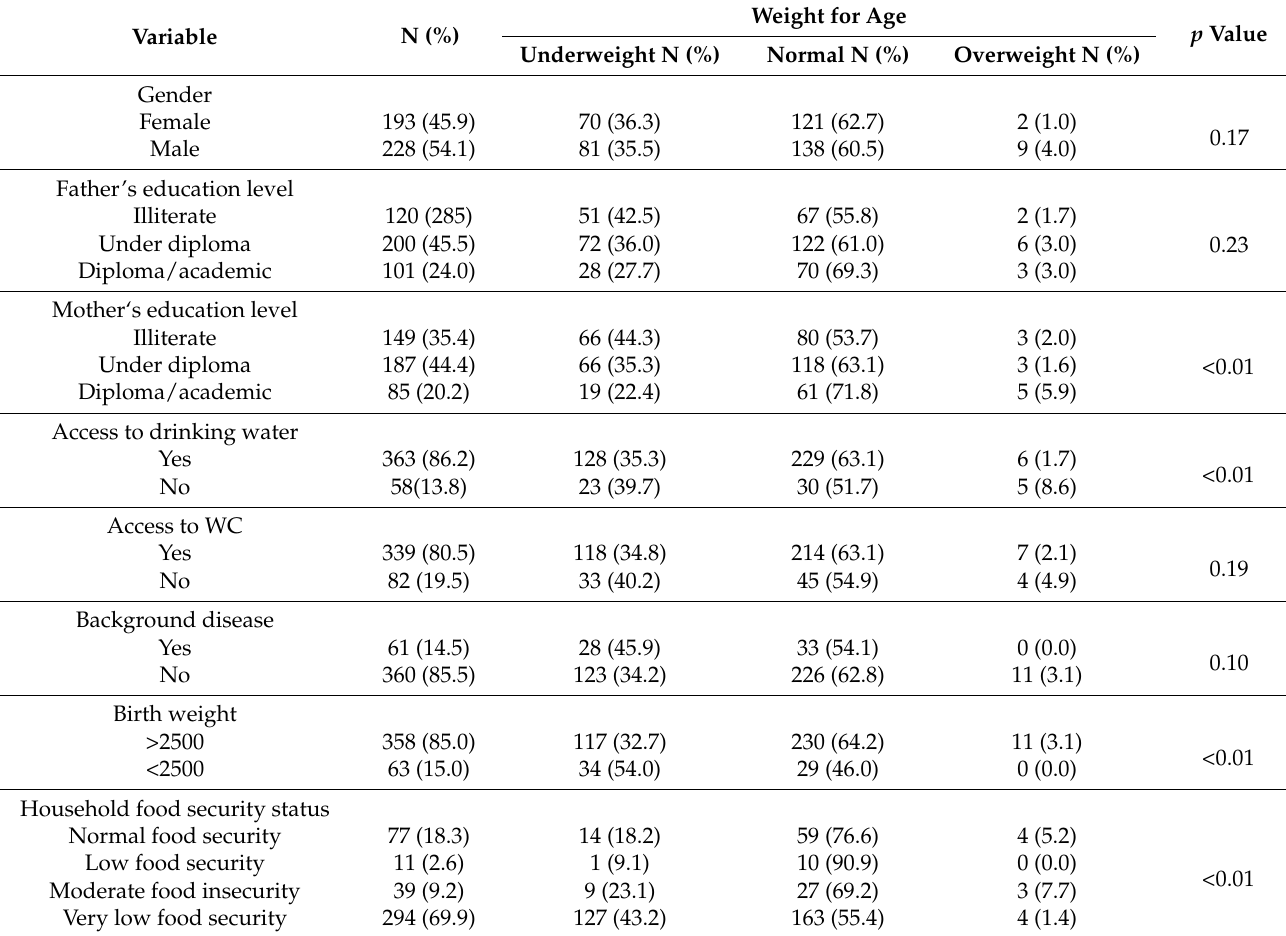
Table 1. The participants’ sociodemographic characteristics by weight for